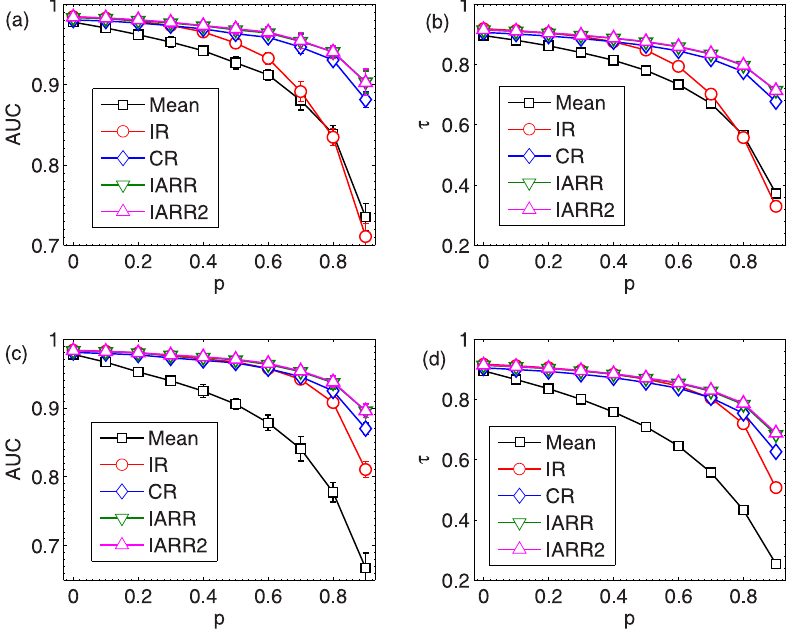
Figure 2. (a) and (b) the AUC and t of different algorithms to random rating spamming. (c) and (d) different algorithms to malicious push rating spamming. The results in this figure are averaged over 10 independent realizations. The error bars are the corresponding standard deviations.